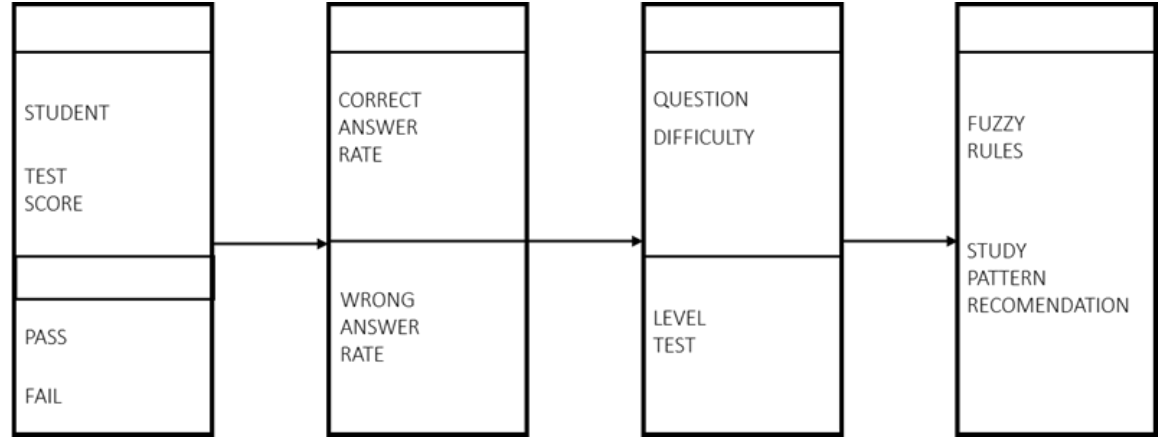
Figure 5. Flow chart of level test based on fuzzy rules.